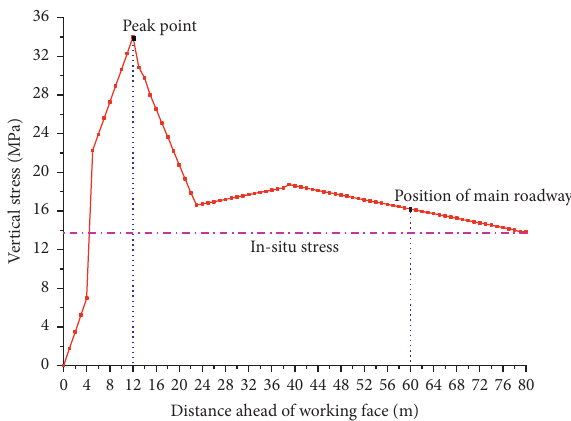
Figure 6: Abutment pressure distribution on the 3209 mining